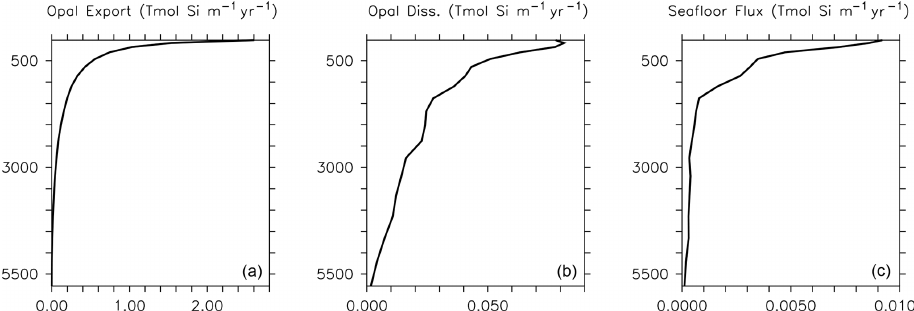
Figure 2. Implicit opal export (a) , water column dissolution (b) and seafloor burial (c) at model year 2014. Rates are globally integrated in the latitudinal and longitudinal planes but depth information is retained. Thus, opal export, dissolution and seafloor flux are reported in Tmol Si flux per metre of depth per